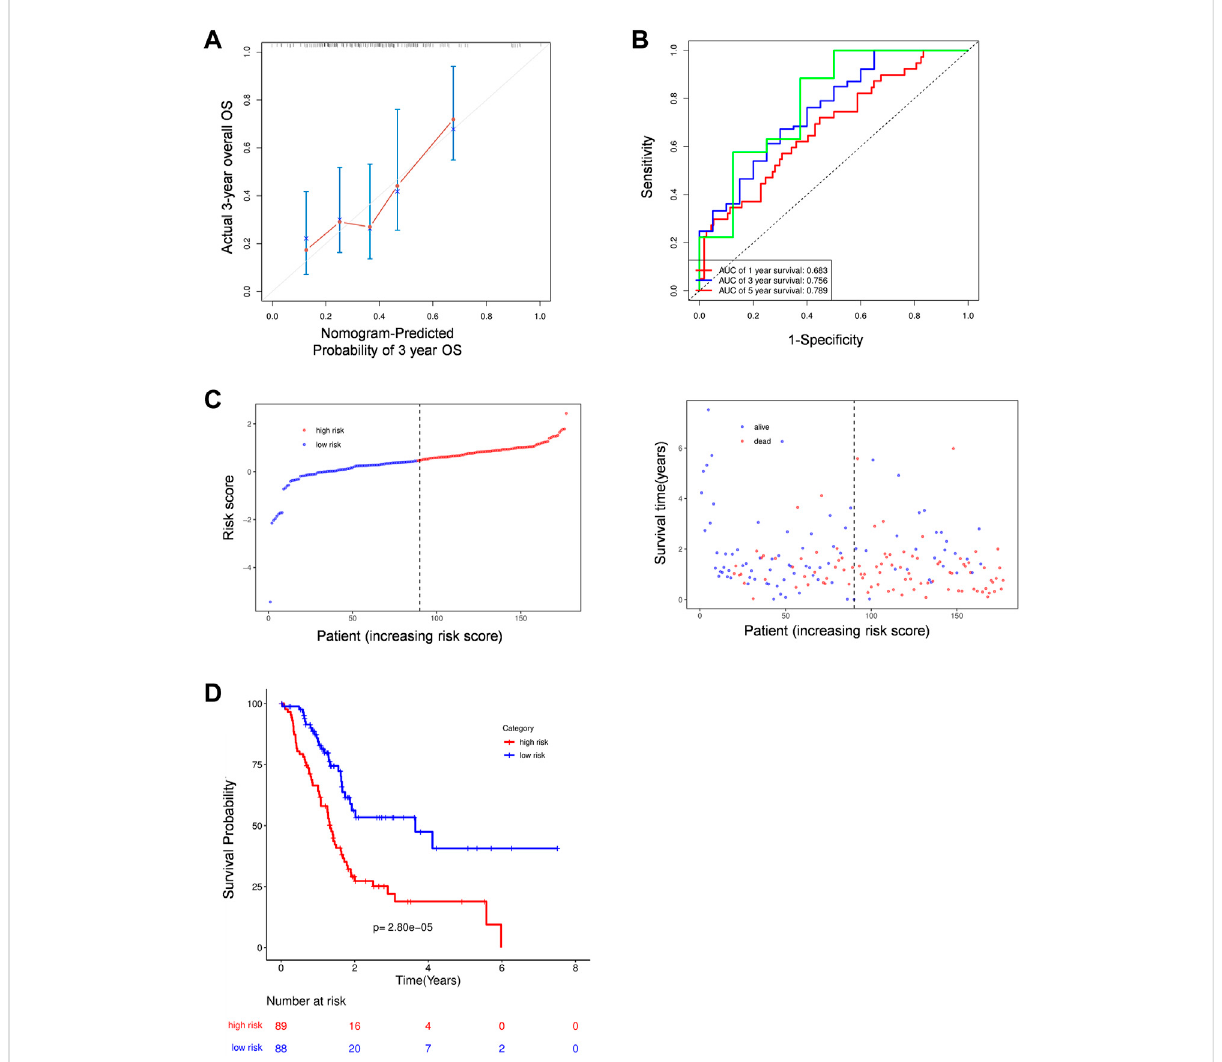
FIGURE 5 The prognostic analysis of PRGs signature. (A) Calibration plots of the nomogram for predicting OS within 3 years basing on PRGs signature in the TCGA cohorts. (B) Time dependent ROC analysis in the TCGA cohort. (C – D) The plots of risk score and alive status (C) as well as Kaplan-Meier survival analysis (D) in the TCGA